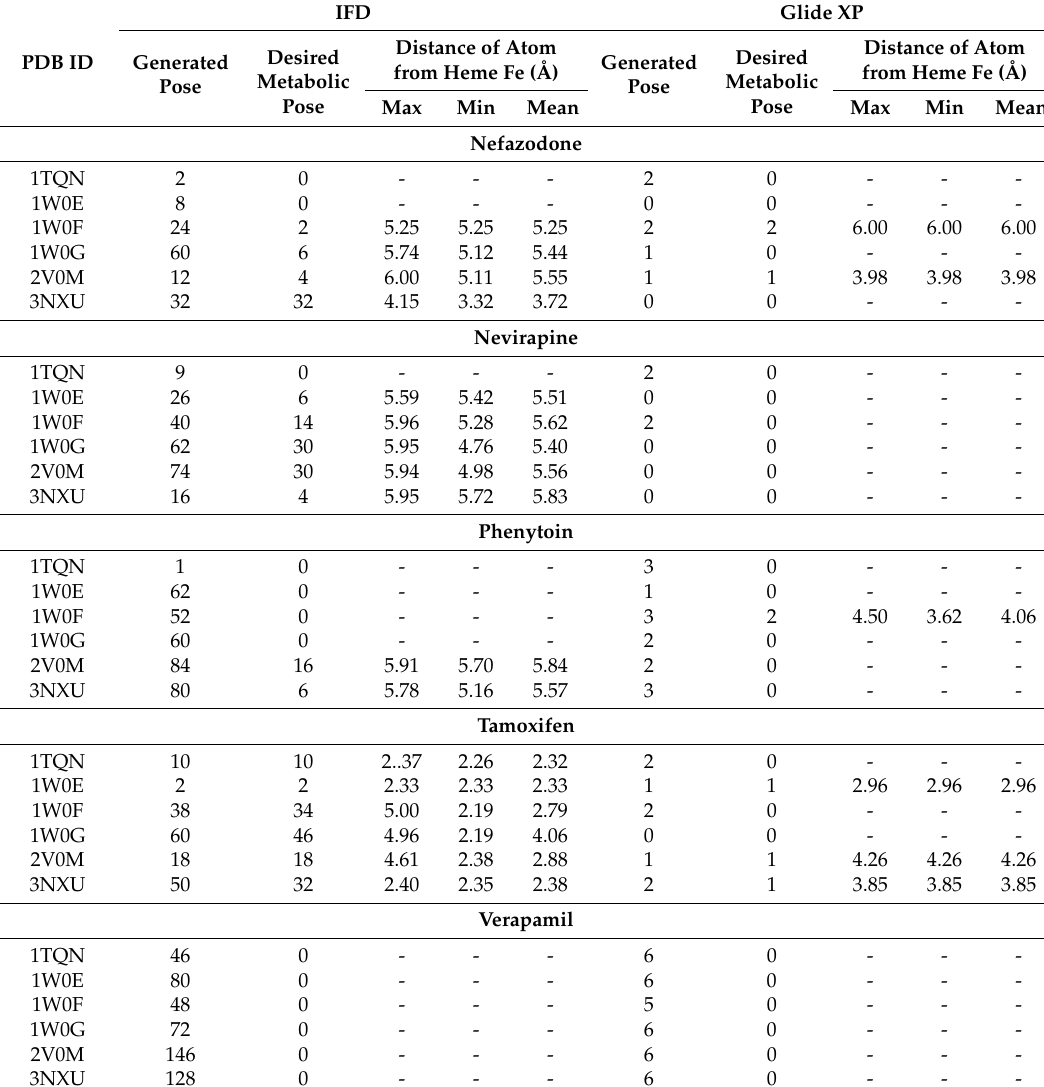
Figure 4. This figure outlines the superimposition of Alprazolam, Nevirapine, and Tamoxifen in the active site of di ff erent CYP3A4 conformation. After analyzing the overall results, both methodologies do not place SOM of some compounds within a distance of 2.5 Å to the heme Fe atom, but it has been found that induced fit docking (IFD) is better than Glide XP to produce favorable metabolic poses for most of the compounds in the active site of